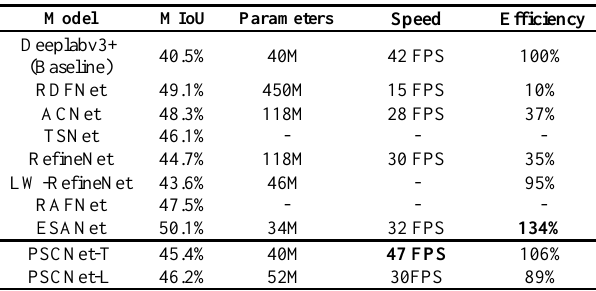
Table 5. Precision and Other Details of Different